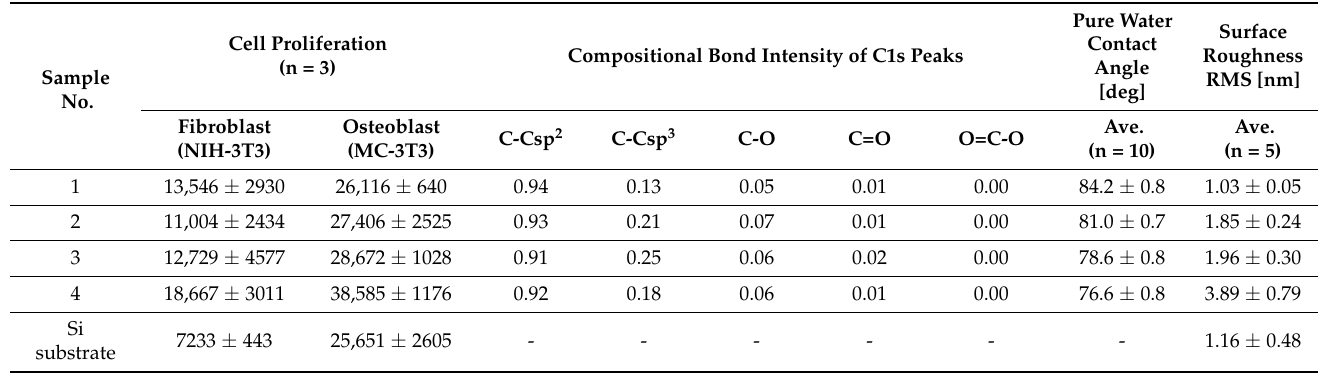
Table 5. Cell proliferation, wettability, surface composition, and surface roughness for each PLC sample.